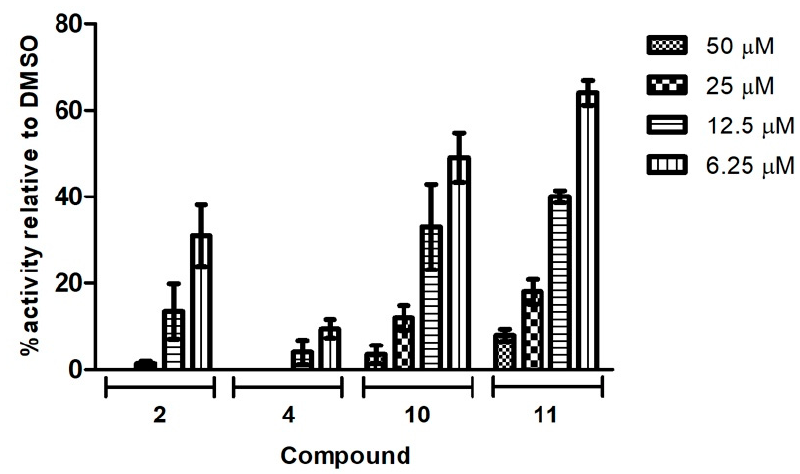
Figure 5. The effect of compounds on TBEV propagation in A549 cells. A549 cells were infected with the TBEV Neudoerfl strain at an MOI of 0.001. After virus removal at 2 h p.i., the cells were washed and overlaid with carboxymethylcellulose in D-MEM medium with DMSO or increasing doses of compounds. At 48 h p.i., cells were fixed and infected foci were visualized by immunostaining with the monoclonal anti-Flavivirus group antigen antibody (4G2). Plaques were counted and presented as a percentage in comparison to the number in DMSO-treated cells expressed as 100%. Error bars indicate standard deviations from three